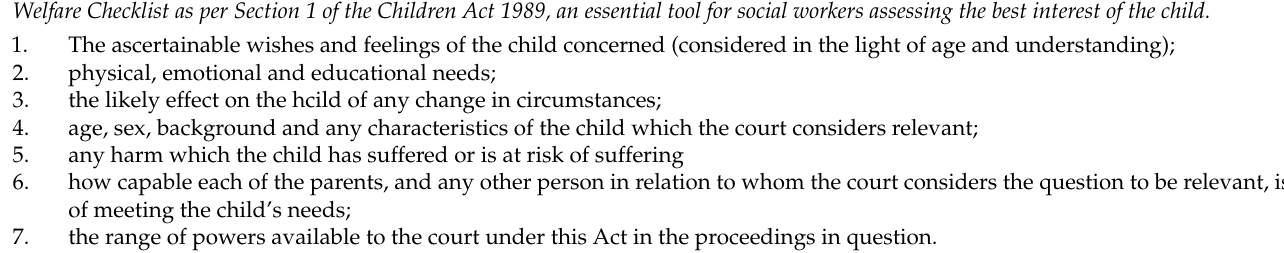
Table 2. The Welfare Checklist as per Section 1 of the Children Act